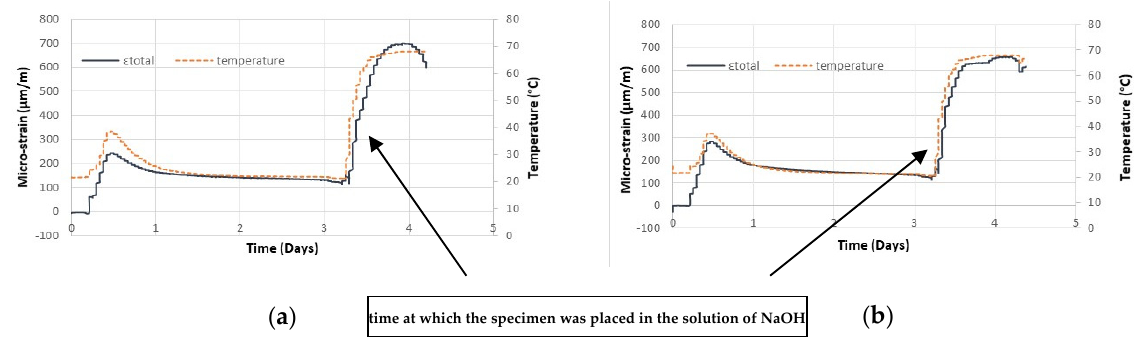
Figure 2. Temperature and strain measurements in: ( a ) prism 2 and ( b ) prism 3.